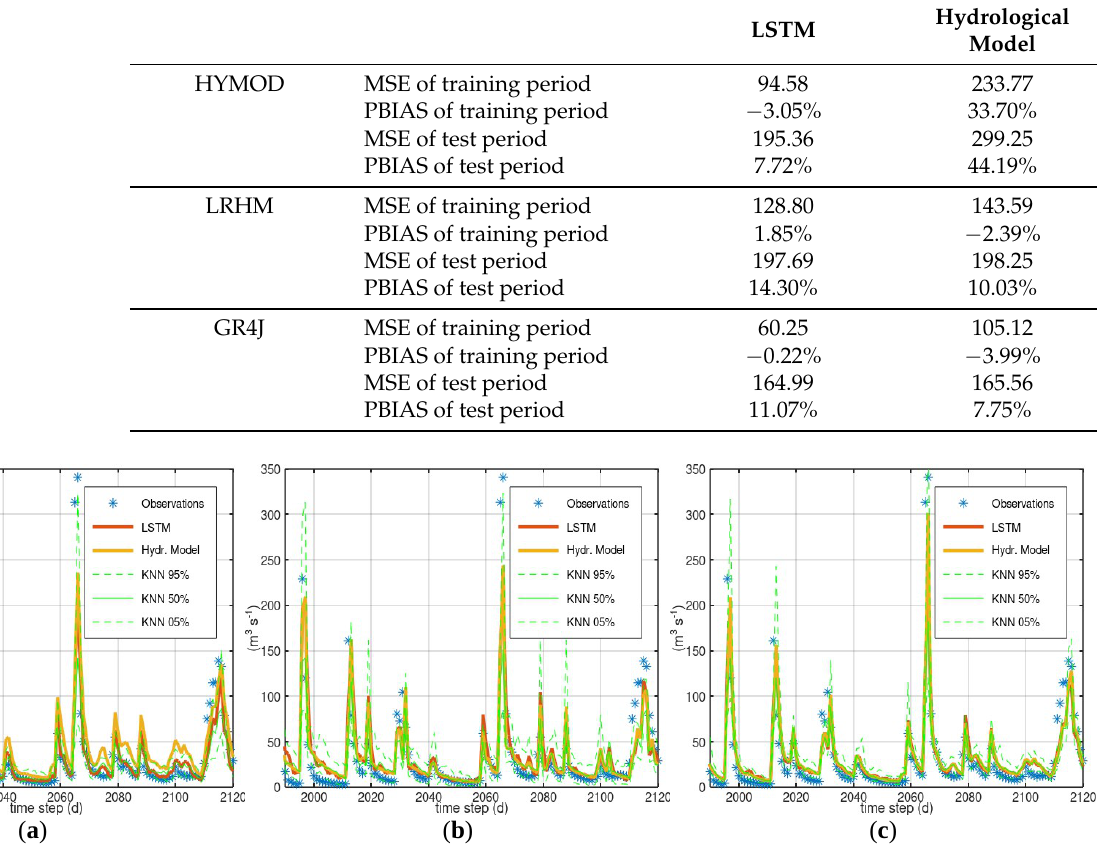
Table 1. Performance indicators of Arno River case study.